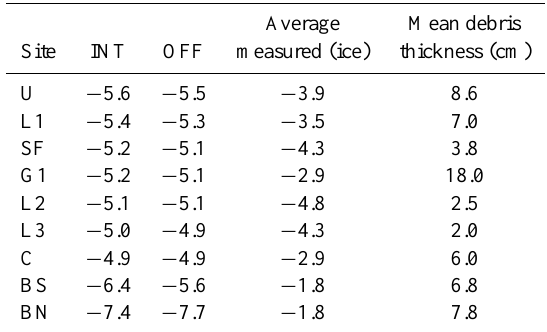
Table 4. Ablation rates (cm day − 1 ) and debris thickness on the Bal- toro glacier.